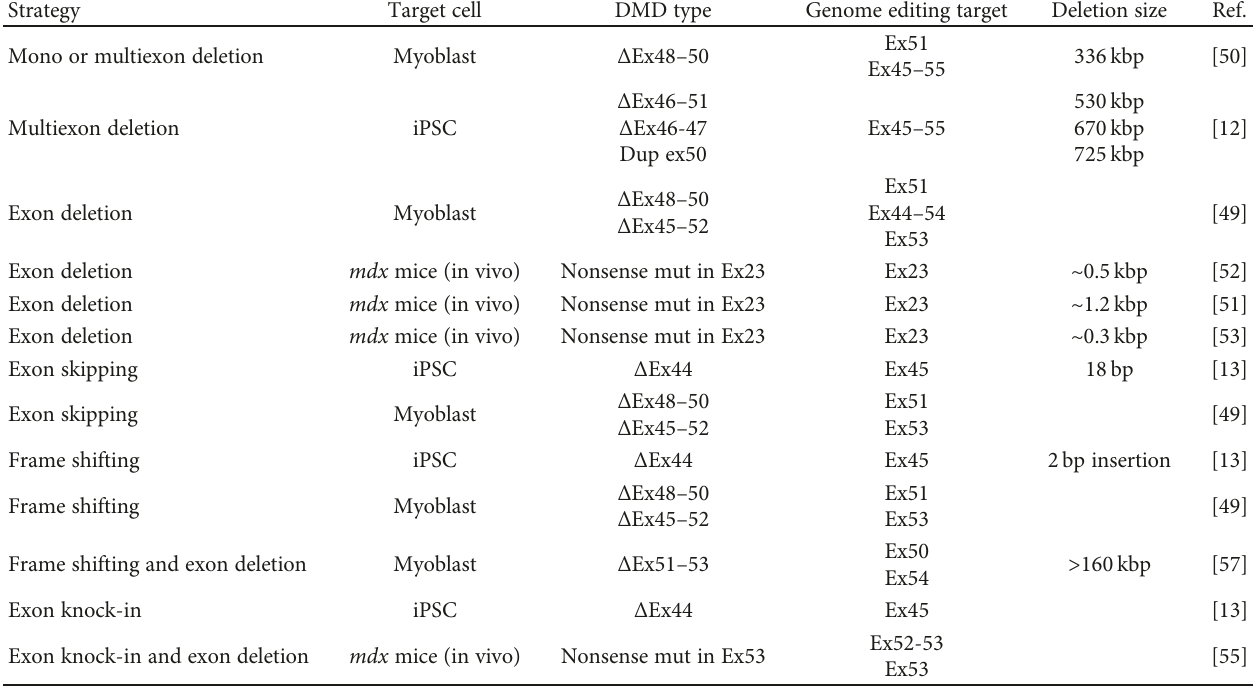
Table 2: Summary of papers utilizing various CRISPR-Cas9 strategies to target DMD mutations in patient-derived cells.